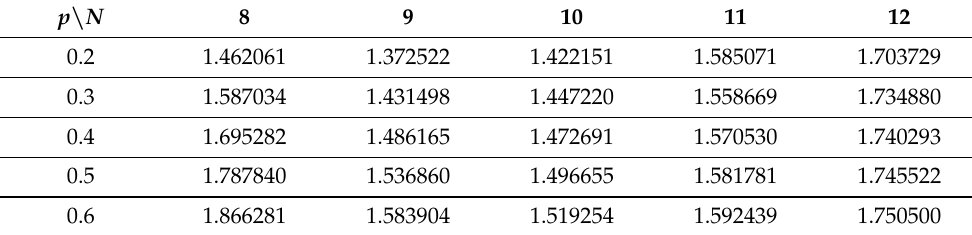
Table 5. Effect of p vs. N on the waiting time of queue.